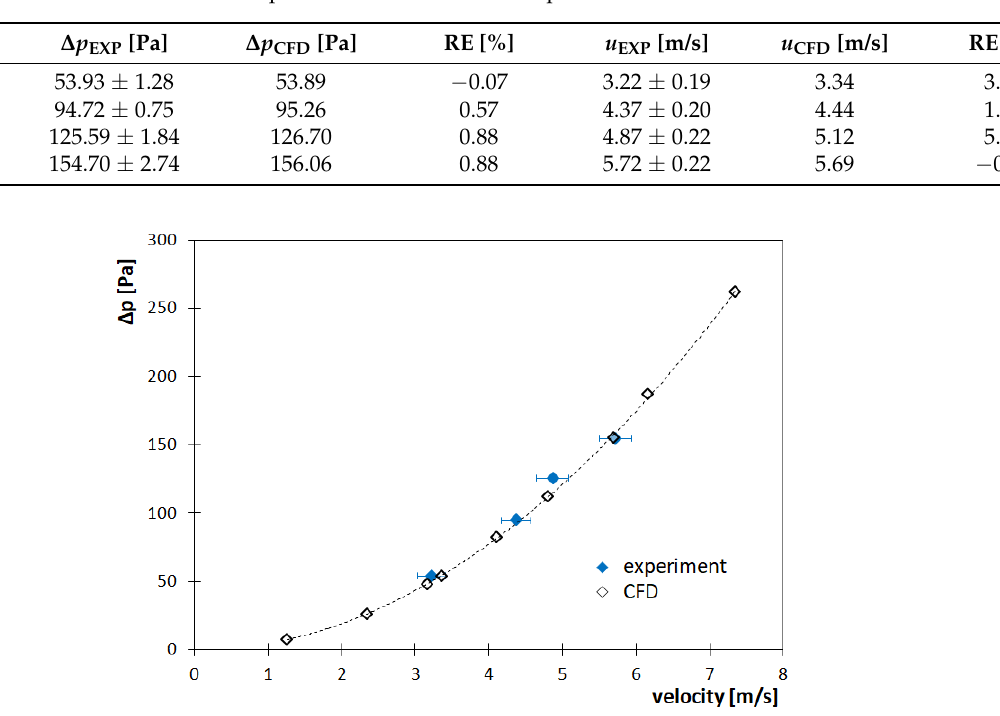
( b ) Figure 6. Velocity profile behind the plate: ( a ) for measurement row No.3 (y = 218 mm); ( b ) for row No.6 (y = 518 mm). Corresponding Δ p = 100 Pa.